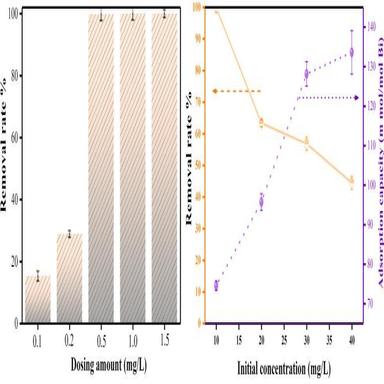
(a) The effect of Bi–O-A dosage on the removal of 10 mg/L As(V), (b) the influence of the initial concertation at the dosage of 0.5 g/L (Test condition: different initial concentration of the As (V), pH under natural, reaction for 240 min, stirring speed 400 rpm, T = 25 ± 1 ◦C).